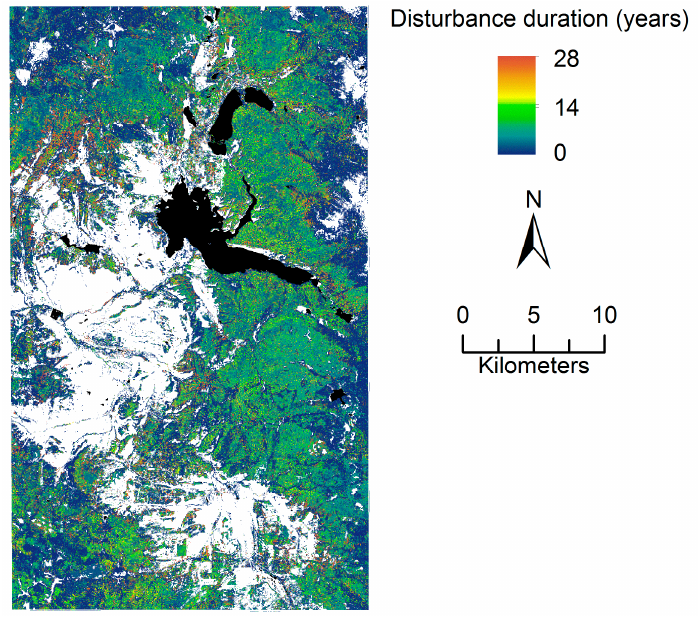
Figure 4. Greatest disturbance duration (GDdur) across the study area, which shows that many areas had been disturbed prior to the bark beetle outbreak that began in 2003. Areas where canopy cover is <10% are masked in white. Water bodies are black.